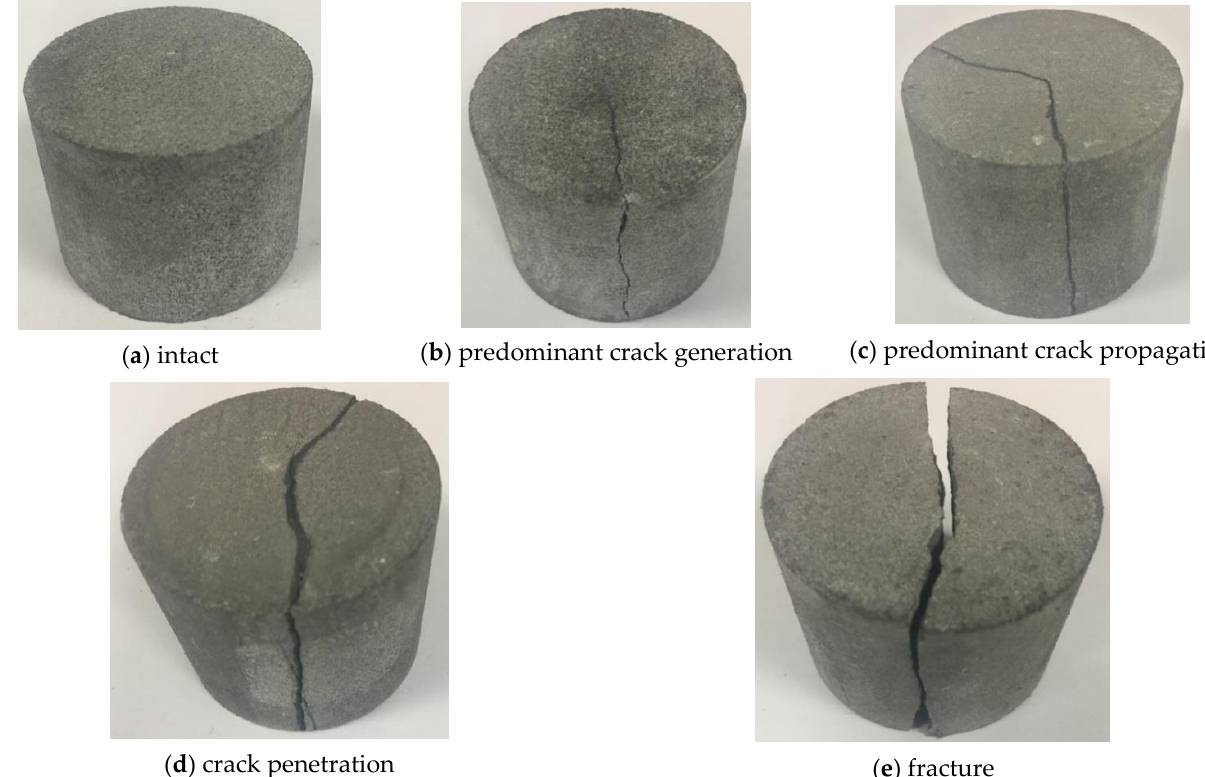
Figure 11. The failure morphology of sandstone under repeated impacts.